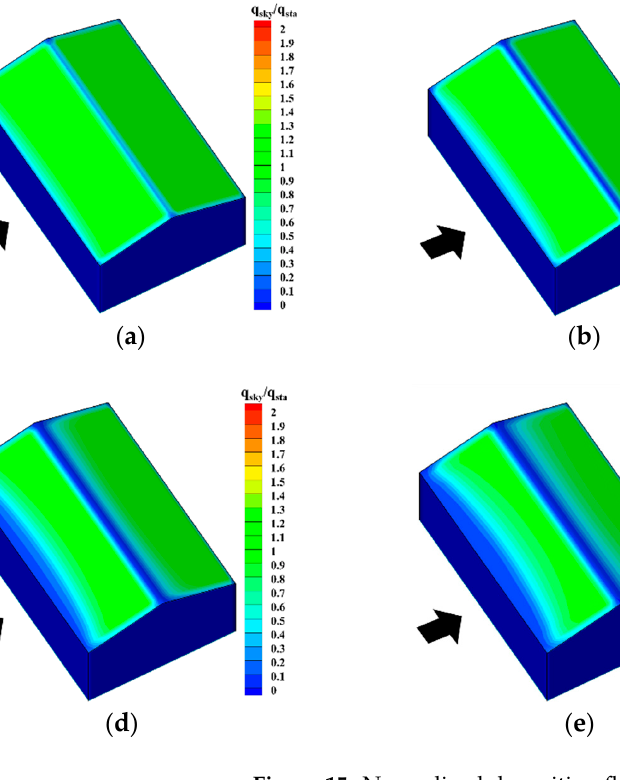
( e ) ( f ) Figure 16. Normalized deposition flux of drifting snow q surf / q sta : ( a ) U H = 2 m/s; ( b ) U H = 3 m/s; ( c ) U H = 4 m/s; ( d ) U H = 5 m/s; ( e ) U H = 6 m/s; ( f ) U H = 7 m/s. ( a ) ( b ) ( c )